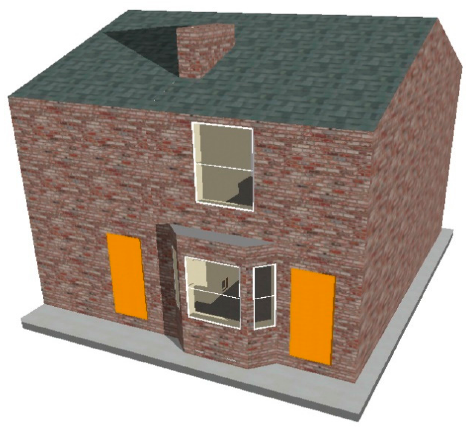
Figure 4. Model of the Energy House test facility in Designbuilder.